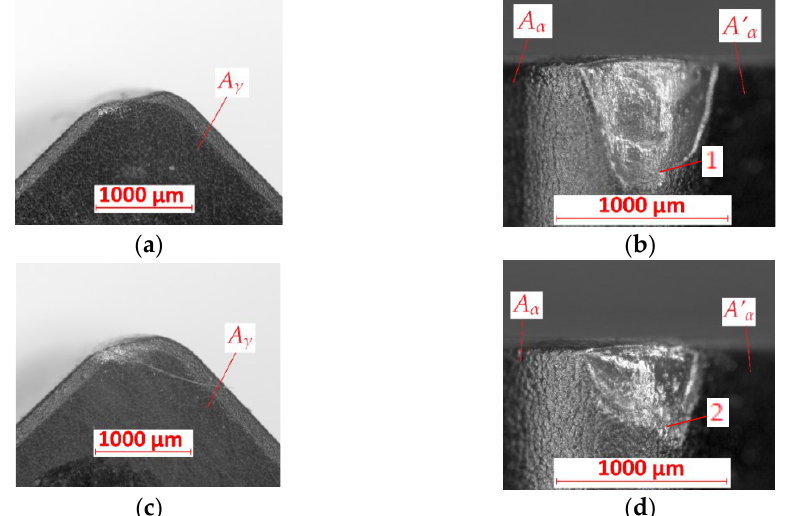
Figure 8. Results of tool ’ s wear measurements of cutting inserts after turning with f = 0.125 mm/rev of ( a , b ) FEPA 046 samples; ( c , d ) FEPA 100 samples: A γ — rake surface, A α — principal flank surface, A ’ α — auxiliary flank surface, 1 , 2 — places of abrasive wear.